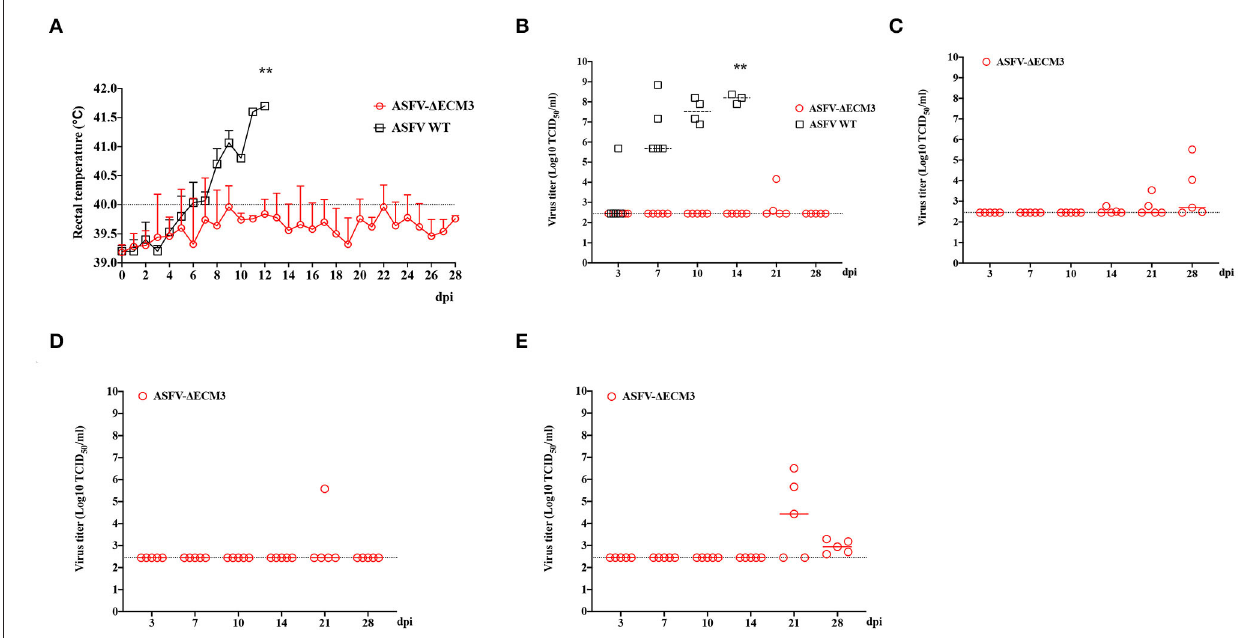
FIGURE 3 | Safety investigation of ASFV- 1 ECM3 as a vaccine candidate in pigs. (A) Body temperature in piglets challenged with ASFV- 1 ECM3 virus and parental GZ201801. (B) Viremia titers were detected in piglets inoculated with ASFV- 1 ECM3 virus. Viral titers of oral swabs (C) , nasal swabs (D) , and anal swabs (E) were evaluated post-infection. The sensitivity of virus detection was ≥ 10 2.45 TCID 50 /ml, which meant Cycle threadhold (Ct) more than 35 might be considered below the limit of detection by qPCR analysis. ** p <